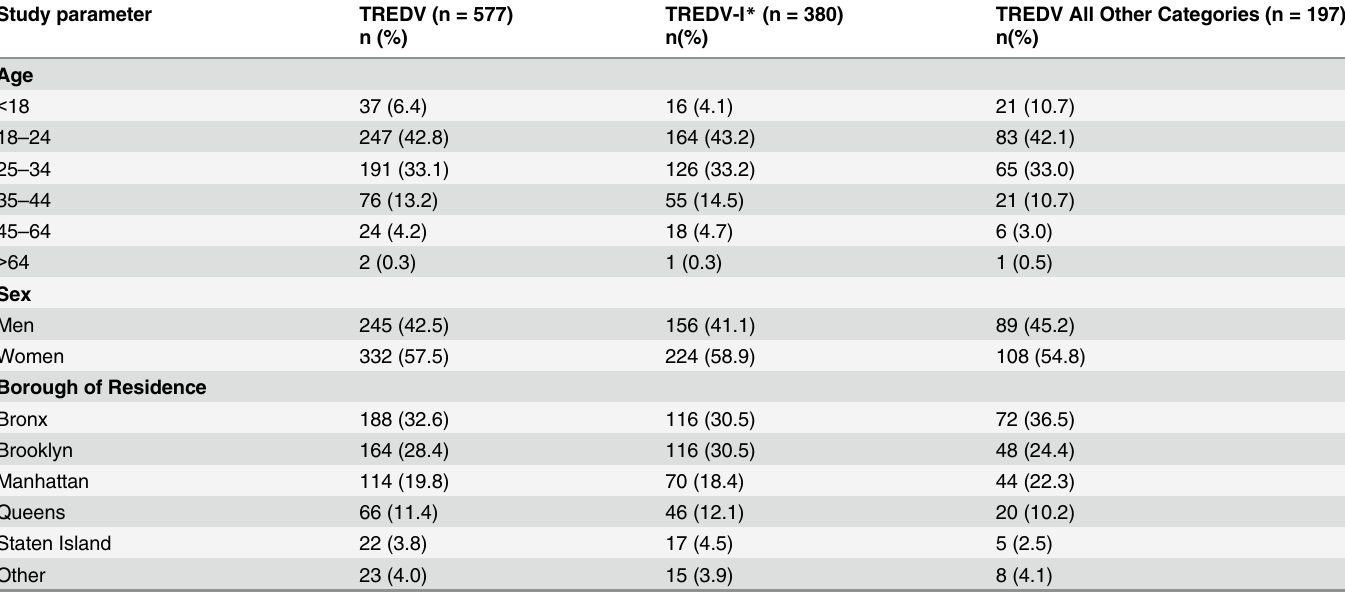
Table 1. Descriptive characteristics of tattoo-related emergency department visits (TREDV), New York City, 2008 – 2012. Study parameter